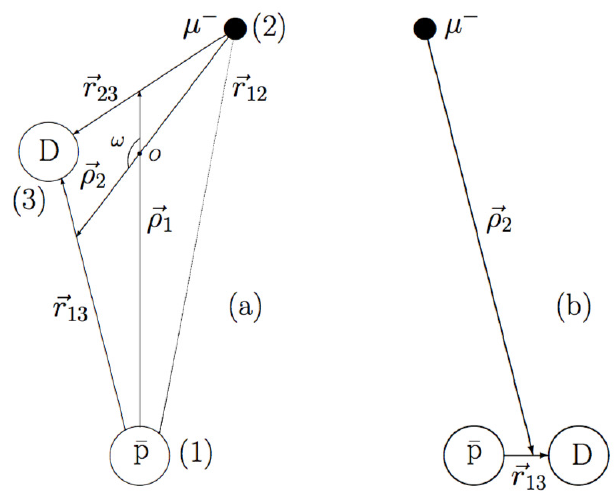
Figure 1. Two spatial coordinate configurations of the Coulomb three-body system ¯p- µ -D. Here: (1) is an antiproton ¯p, (2) is a negative muon µ − , and (3) is the deuterium nucleus D. Vectors (cid:30) r , (cid:30)ρ and 13 2 } are few-body Jacobi coordinates of the input and output channels of the reaction (2) { correspondingly, O is the center of mass of the three-body system and ω is the angle between the Jacobi vectors (cid:30)ρ 1 and (cid:30)ρ 2